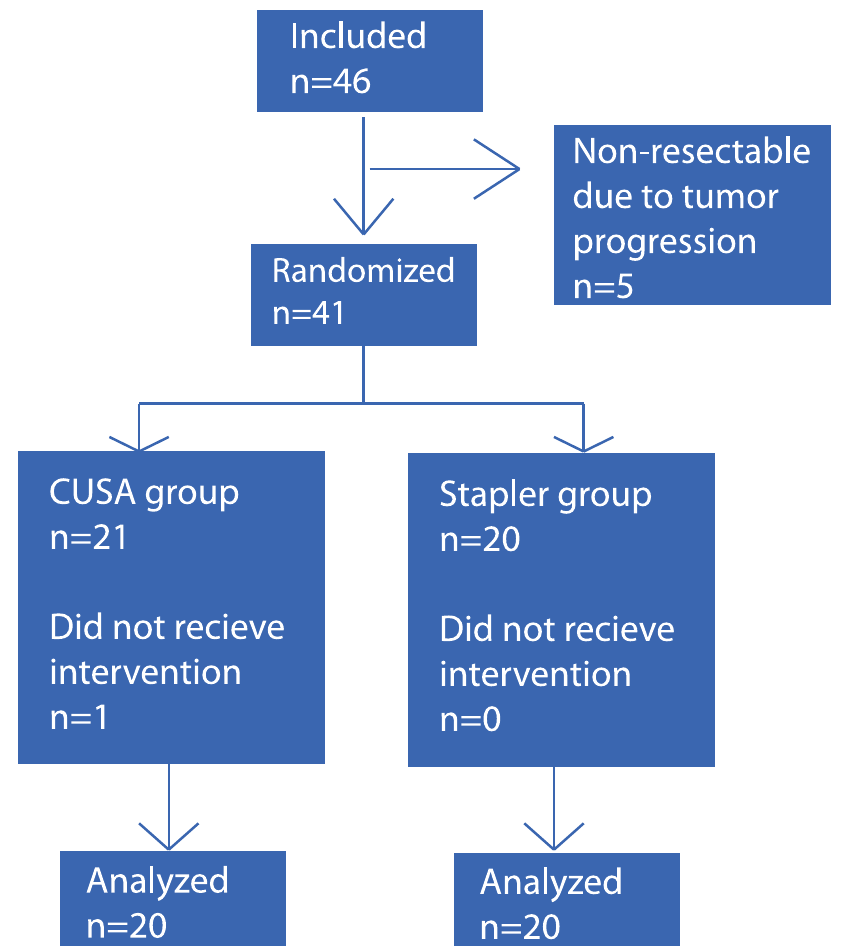
Fig 1. Enrollment and randomization. Forty-six patients were enrolled for this study. In five patients liver resection was not performed due to tumor progression. The remaining 41 patients were randomized intraoperative and assigned to CUSA resection (n = 21) or stapler hepatectomy (n = 20). One patient from the CUSA group was excluded after randomization, as the patient emerged to be non-resectable.